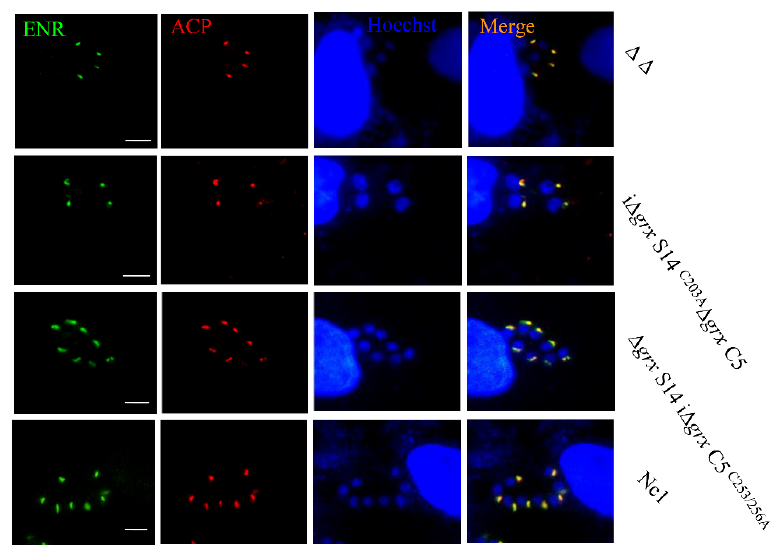
Figure 7. Location of apicoplast proteins in grx S14 and grx C5 deletion and mutant strains. Locations of ENR (green) and ACP (red) in com ∆ grx S14 AXXS ∆ grx C5, ∆ grx S14com ∆ grx C5 AXXA , com ∆ grx S14 ∆ grx C5, ∆ grx S14com ∆ grx C5, ∆ grx S14 ∆ grx C5 and Nc1 strains were detected by IFA. Parasite shapes were visualized with anti-NcSRS2 (red); nuclear DNA was stained with Hoechst (blue). Scale bar = 5 μ m.